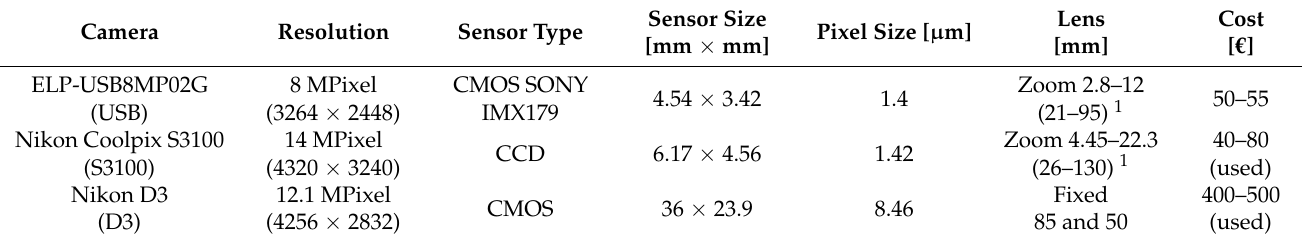
Table 2. Technical specifications of the three tested camera systems.